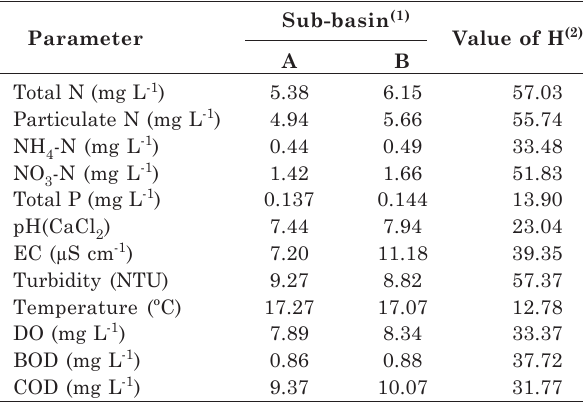
Table 7. Annual average concentrations of